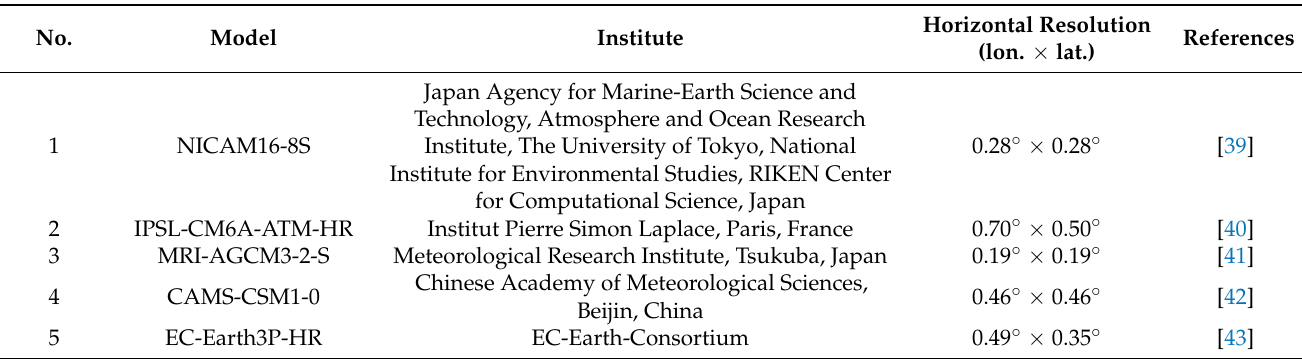
Table 1. Details of the 5 CMIP6 HighResMIP models used in this